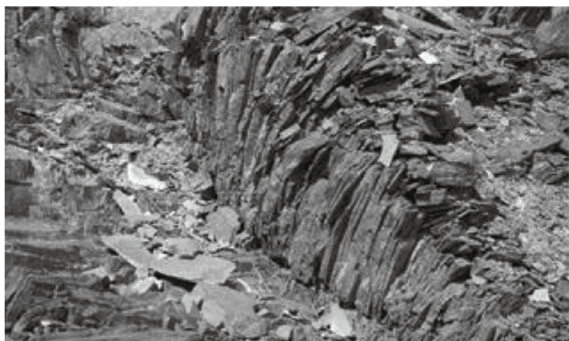
Figure 4: Typical cross-section of the mining